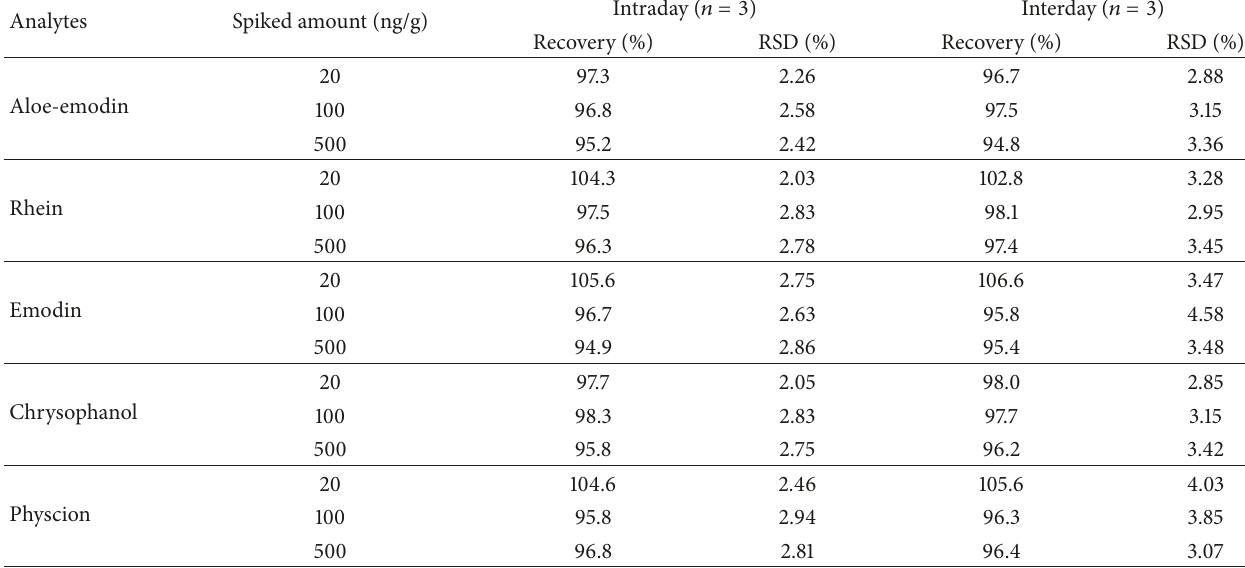
Table 2: The interday and intraday precision and recoveries of the